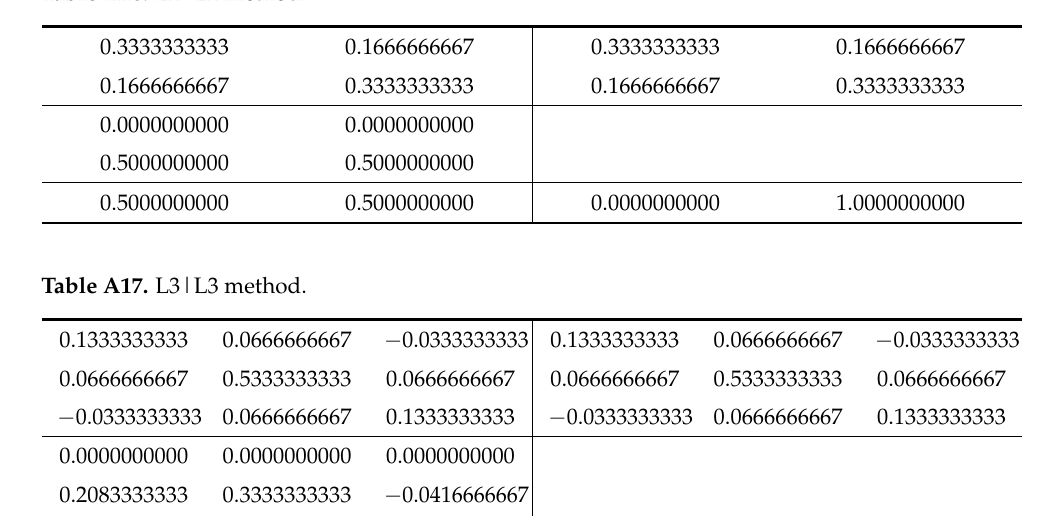
Table A16. L2|L2 method.